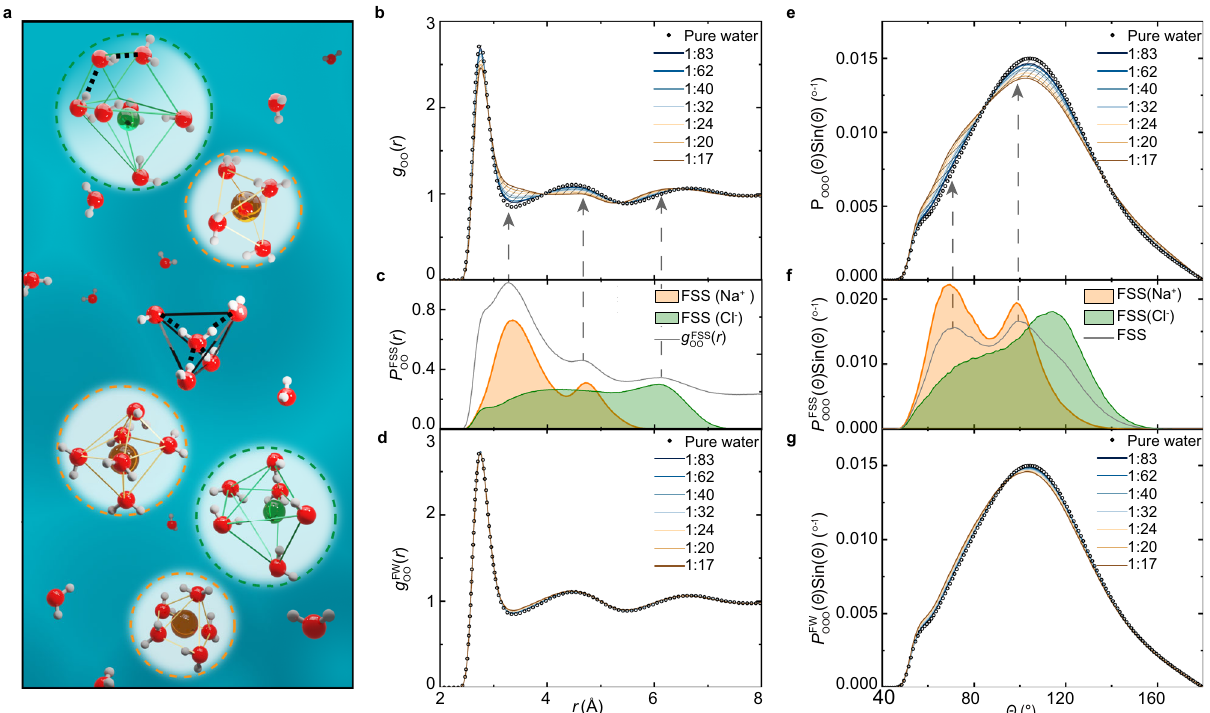
Fig. 3 Structure of NaCl solutions. a Schematic diagram of the microscopic structure of the NaCl solution. Red, white, yellow, and green spheres represent the O, H, Na + , and Cl − atom/ion, respectively. The dashed yellow/green circles show FSSs of Na + /Cl − , the radius of which was de fi ned as the fi rst minimum of the O – Na/O – Cl RDF. The dashed black lines represent hydrogen bonds between water molecules. The hydrogen-bond chain in the FSS of Cl − indicates the partial recovery of the tetrahedral structure of water. b O – O RDFs, g oo r ð Þ ; for pure water and NaCl solutions at various indicated concentrations. c O – O distance probability distributions in the FSS of a Na + or Cl − ion, P FSS r ð Þ . The gray line g FSS r ð Þ is the contribution of all FSSs to g oo r ð Þ . oo oo The absolute value of g FSS r ð Þ is scaled. d O – O RDFs of FW, g FW r ð Þ , for NaCl solutions compared with g oo r ð Þ for pure water. e O – O – O ADFs, P OOO ð θ Þ , for pure oo oo water and NaCl solutions. f O – O – O ADFs, P FSS ð θ Þ , for the FSSs of Na + , Cl − , and both Na + and Cl − . g O – O – O ADFs of FW, P FW ð θ Þ , for NaCl solutions OOO OOO compared with P OOO ð θ Þ for pure water. The 1:10 results are not presented because the excluded volume correction is inapplicable 17 . Magni fi ed differences of NaCl solutions with respect to neat water are presented in Supplementary Fig.